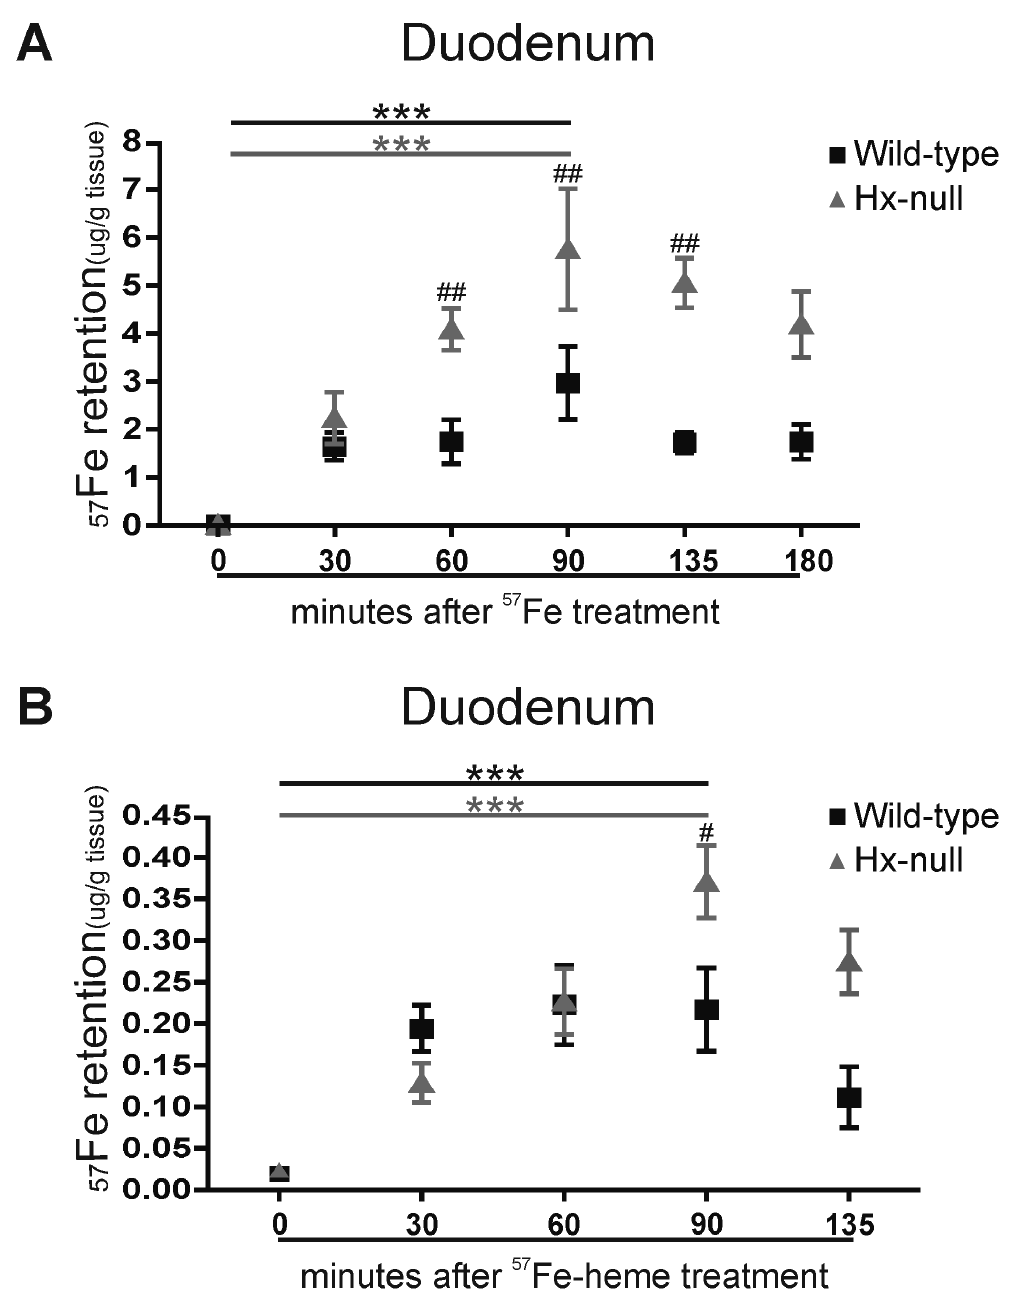
Figure 6. Hx deficiency results in enhanced iron uptake in the duodenum cells. (A) 57 Fe retention in the duodenal mucosa of wild-type and Hx-null mice measured by ICP-MS 30, 60, 90, 135 and 180 minutes after oral administration of a solution containing 20 mmol/L 57 FeSO . Control mice were administered vehicle solution and represented the “0” time point of the experiment. Values 4 are expressed as μg 57 Fe/ g tissue. Data represent mean ± SEM; n=6 for each experimental point; *** = P<0.001 (comparing control mice with the corresponding group of 57 FeSO -administered mice), # # = P<0.01 (comparing the two genotypes). (B) 57 Fe retention 4 in the duodenal mucosa of wild-type and Hx-null mice measured by ICP-MS 30, 60, 90 and 135 minutes after oral administration of a solution containing 20 mmol/L 57 Fe labelled heme ( 57 Fe-heme). Control mice were administered vehicle solution and represented the “0” time point of the experiment. Values are expressed as μg 57 Fe/ g tissue. Data represent mean ± SEM; n=6 for each experimental point; *** = P<0.001 (comparing control mice with the corresponding group of 57 Fe-heme-administered mice), # = P<0.05 (comparing the two genotypes). doi: 10.1371/journal.pone.0068146.g006 PLOS ONE |